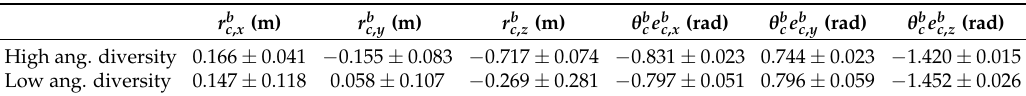
Figure 11. Ladybird and Shrimp platform MCMC axis-angle unit vector ( e b s ) samples plotted on a sphere ( a , d ) and close-up, centred to a pole ( b , e ) (using 16 and 14 observations for Ladybird and Shrimp respectively). Each point on the sphere is coloured according to a KDE to give an indication of the axis-angle vector marginal likelihood for visualisation purposes only. Points were randomly thinned by ten to facilitate plotting. A histogram of the magnitudes of the axis-angle rotation, θ b s , is shown in ( c , f ). The hand measured pose orientation is shown with red crosses in ( a , b , d , e ), and a vertical red line in ( c , f ). Table 4. Angular diversity